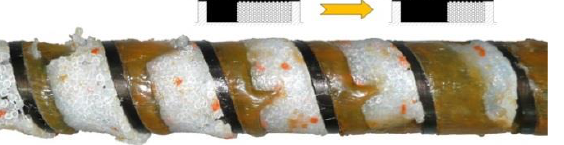
Figure 2. Melting mechanism (CSM) at flood fed single screw extrusion of polypropylene [8].